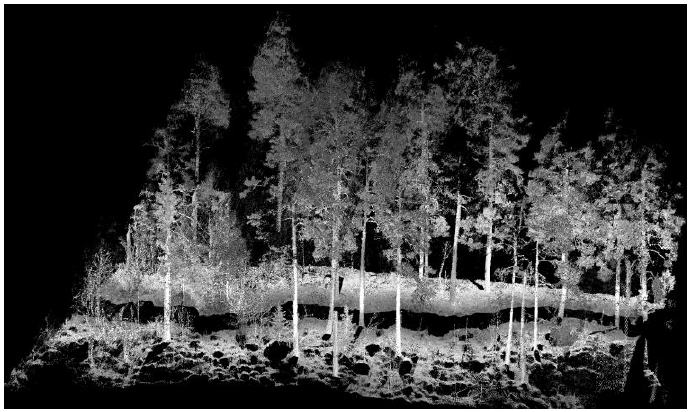
Figure 4. Point cloud data in the test plot utilizing